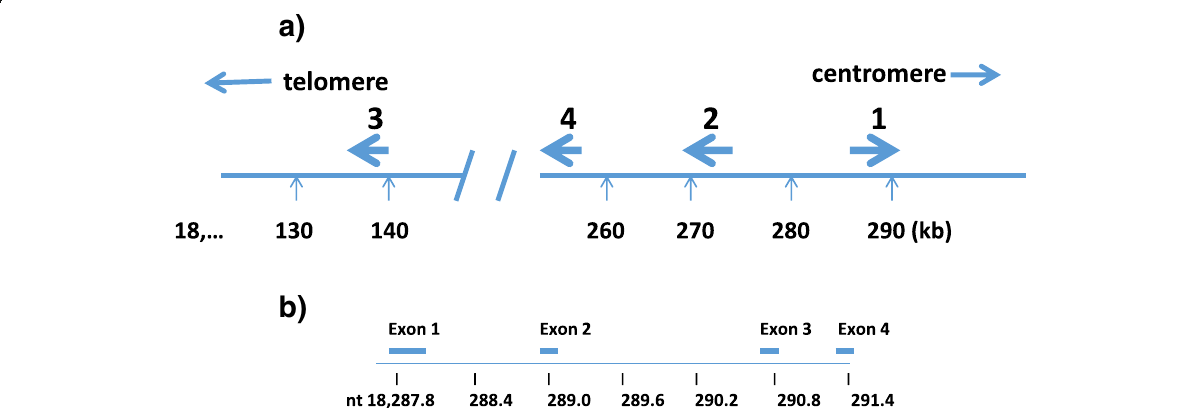
Fig. 5 a Organization of the four members of the human Saa gene family on chromosome 11p. b Exon/intron structure of human SAA1 gene (a common pattern for all Saa gene family